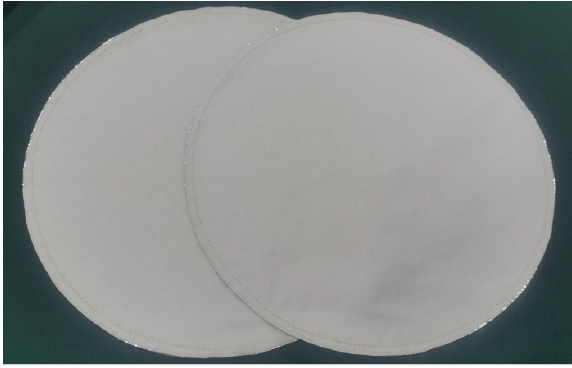
Figure 7. Sample of new insulation material.